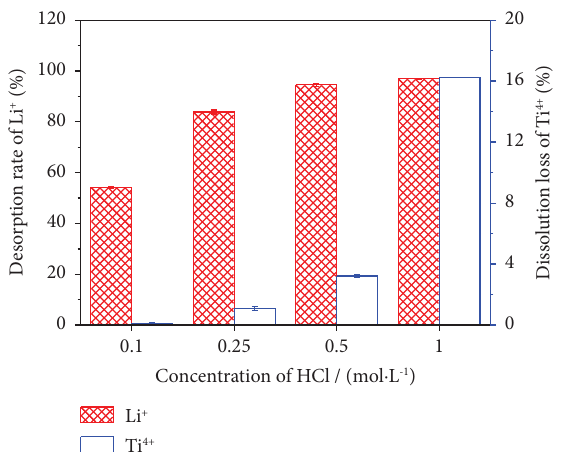
Figure 12: Efect of acidity on preparation precursor from microsphere CMC-LTO-EGDE-ME by Li + desorption.